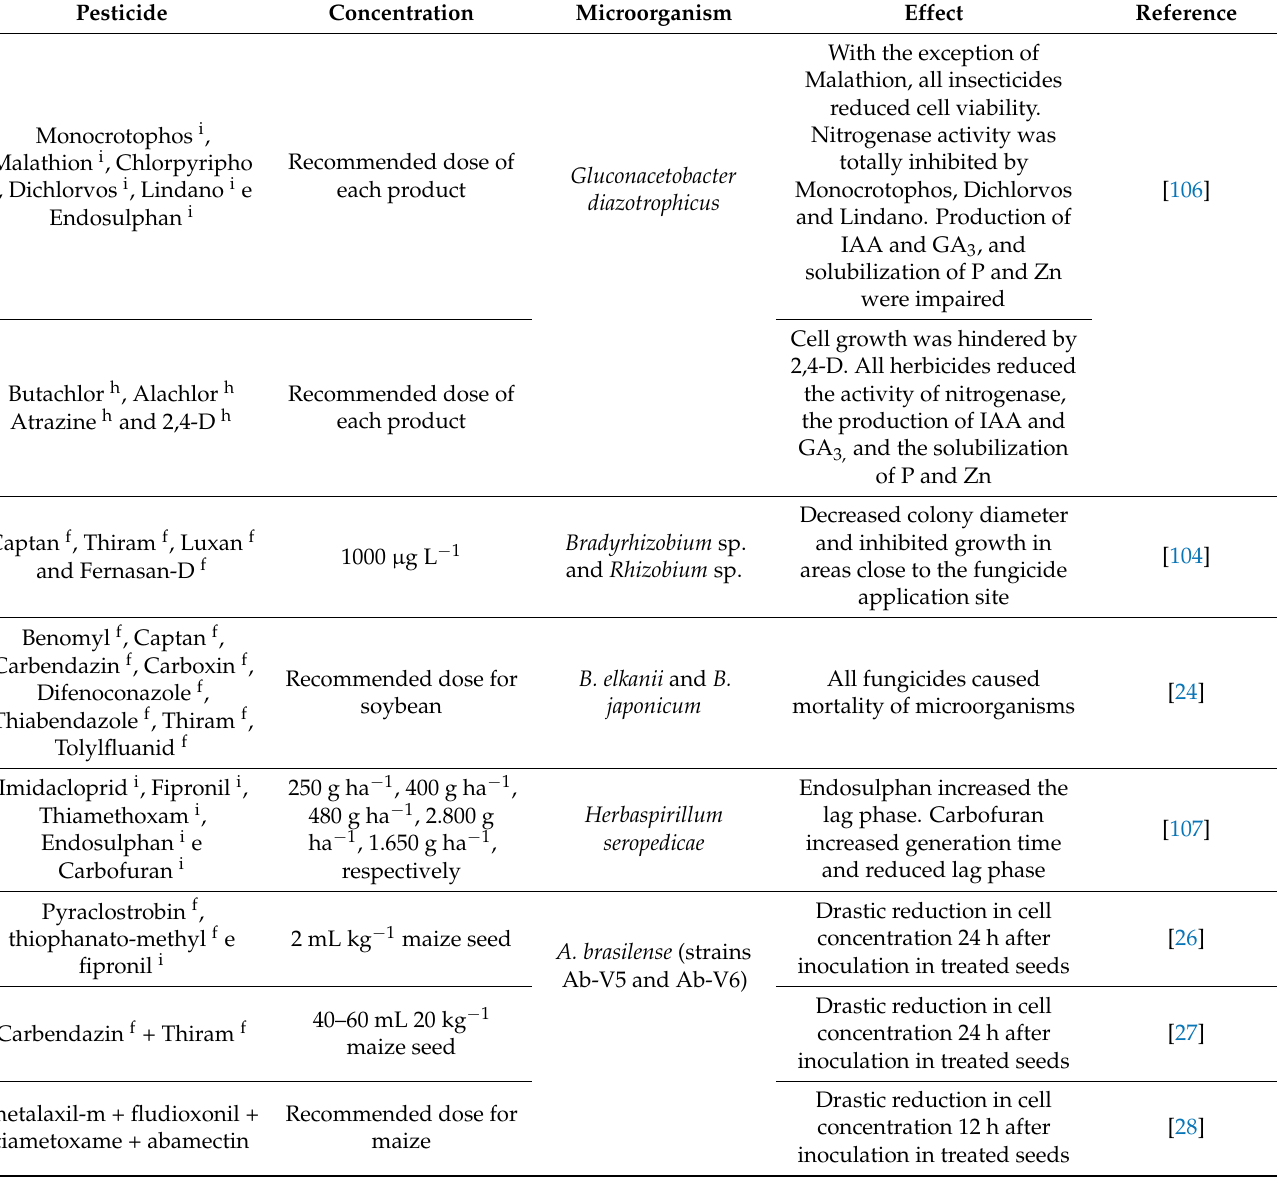
Table 1. Effect of pesticides on cell viability and/or morphology and on the metabolism of microorganisms used as